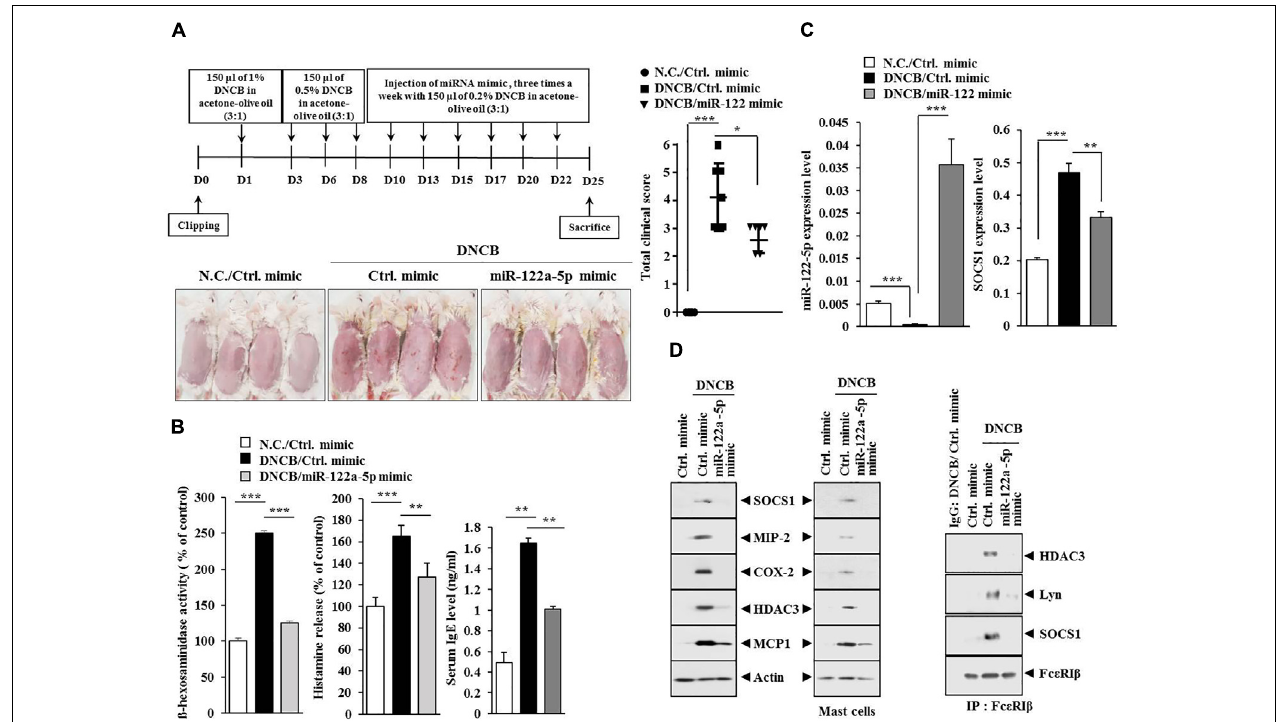
FIGURE 8 | miR-122a-5p mimic inhibits DNCB-induced AD. (A) Shows the experimental time line to determine the effect of miR-122a-5p mimic on AD (upper). Lower figure shows the effect of miR-122a-5p mimic on clinical symptoms associated with AD. ∗ p < 0.05; ∗∗∗ p < 0.0005. (B) Tissue lysates from the mice of each experimental group were subjected to ß-hexosaminidase activity assays (left). Sera of BALB/c mice were employed for the determination of histamine release (middle) and IgE level (right). ∗∗ p < 0.005; ∗∗∗ p < 0.0005. (C) Tissue lysates from the mice of each experimental group were subjected to qRT-PCR analysis. ∗∗ p < 0.005; ∗∗∗ p < 0.0005. (D) Tissue lysates from the mice of each experimental group were subjected to western blot analysis (upper) or immunoprecipitation (lower) by employing the indicated antibody (2 µ g/ml). Mast cell lysates from the skin tissue of the mice of each experimental group were also subjected to western blot analysis (upper right). Tissue lysates from BALB/c mouse injected with control (ctrl.) mimic following the induction of AD by DNCB were immunoprecipitated with isotype-matched IgG antibody (2 µ